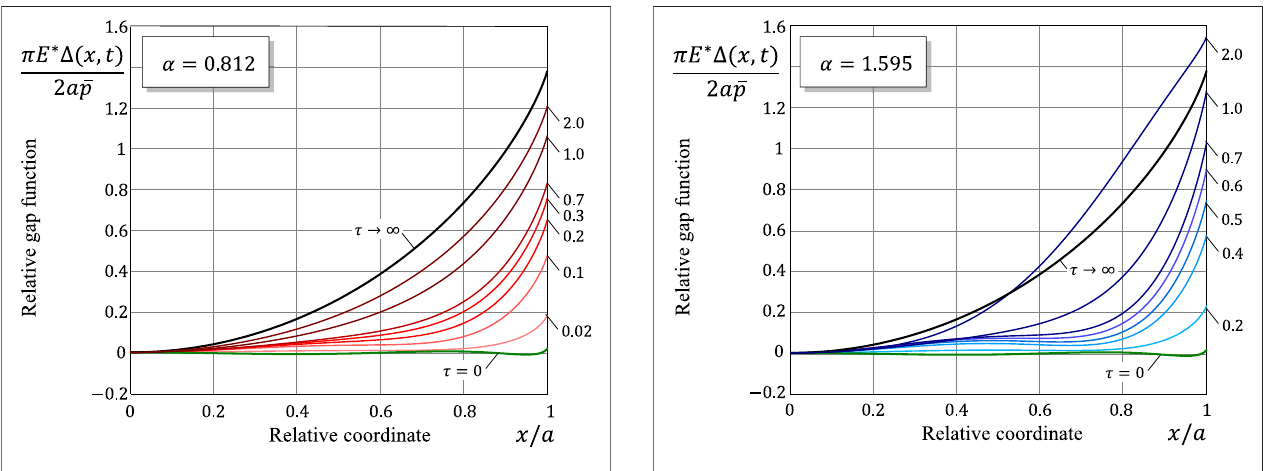
FIGURE 10 | Space-variation of the gap function for different values of the relative time variable τ = t / τ in in the super-Archard wear case.